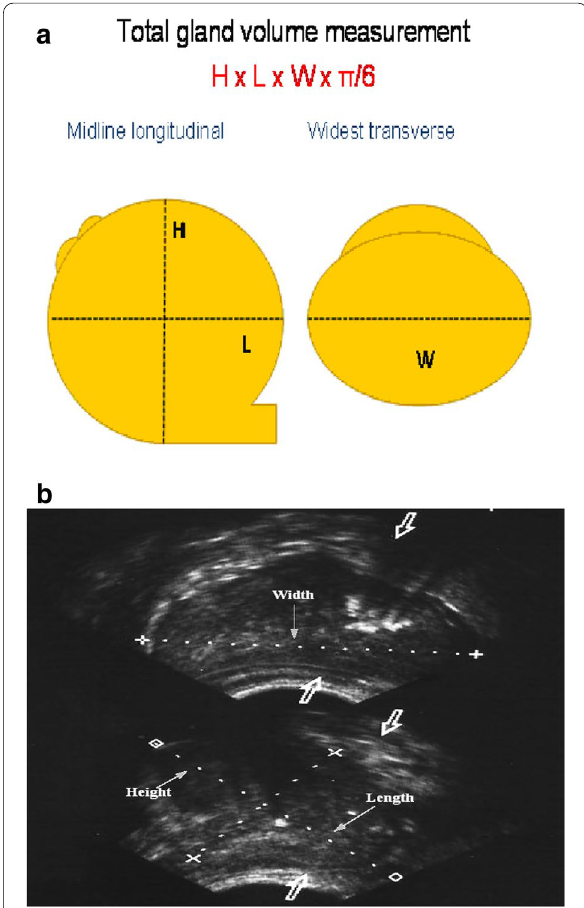
Fig. 1 Total gland volume measurements in transverse and longitudinal views. A Total gland volume measurement concept. B Total gland volume measurements by TRUS in transverse and longitudinal views